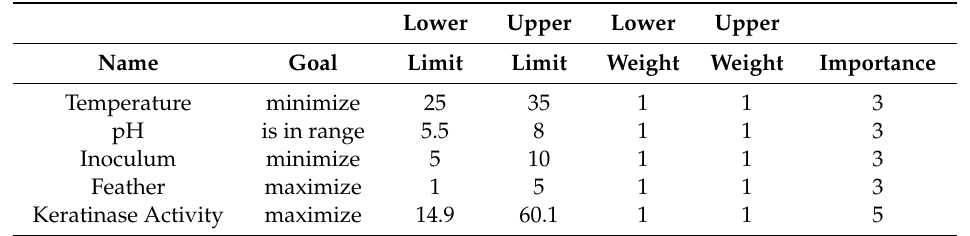
Table 5. Numerical optimization for selected criteria for keratinase activity by Bacillus sp. strain UPMAGG-1.